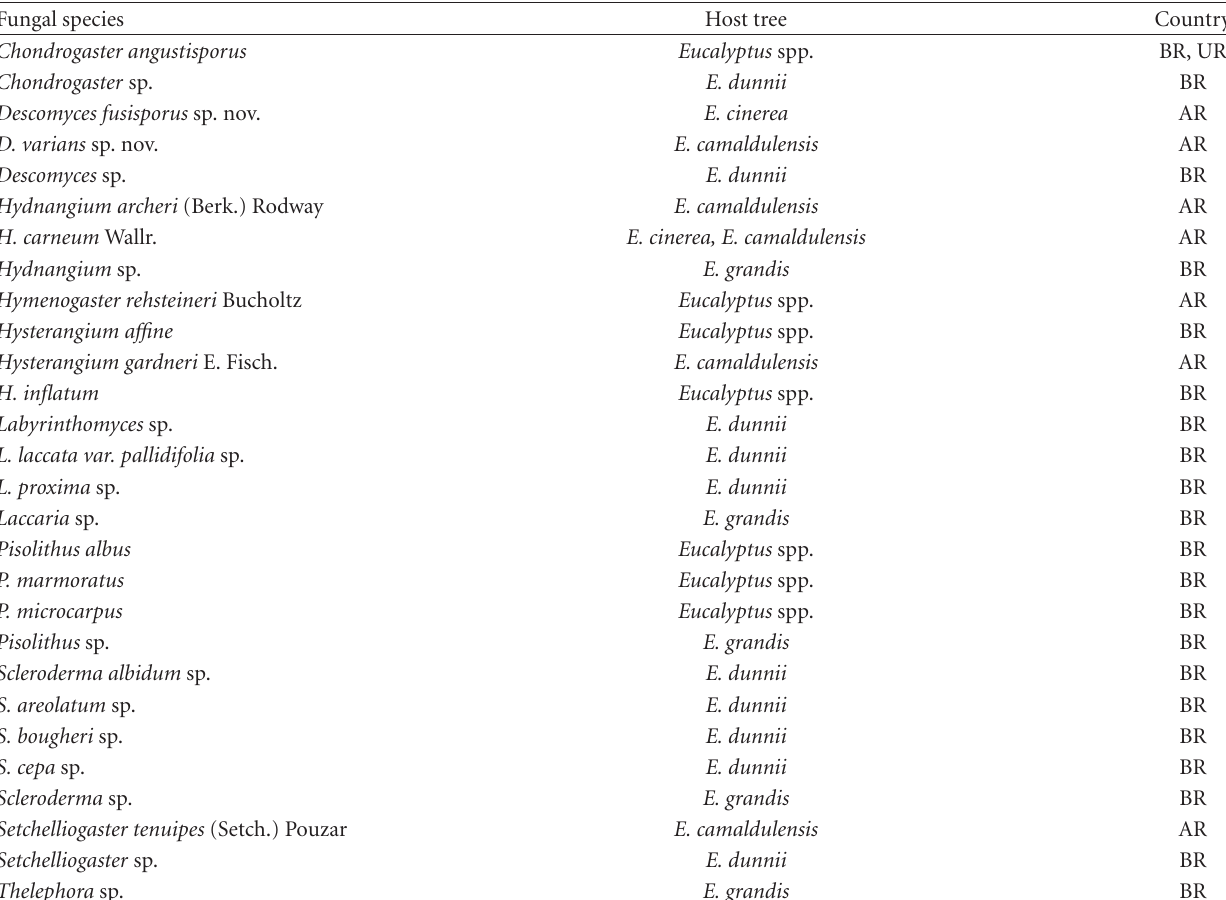
Table 4: List of some ecm fungi and associated eucalypt hosts spontaneously found in South America: Brazil (BR), Uruguay (UR), and Argentina